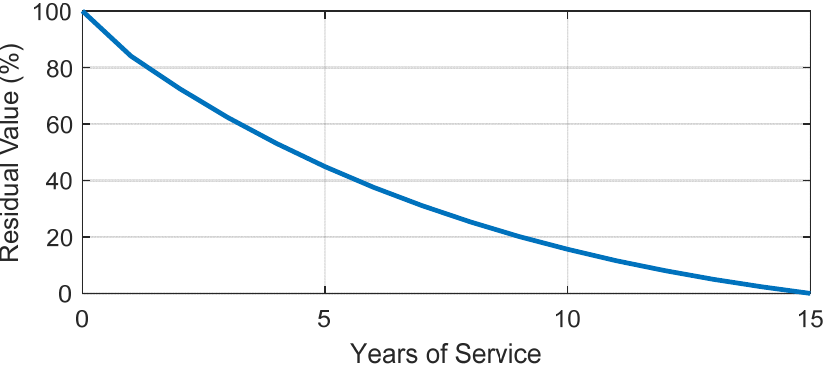
Figure 1. Variation of assumed residual value of a truck as a percentage of purchase price as a function of the years of service. Table 6. Assumptions for TCO calculation.